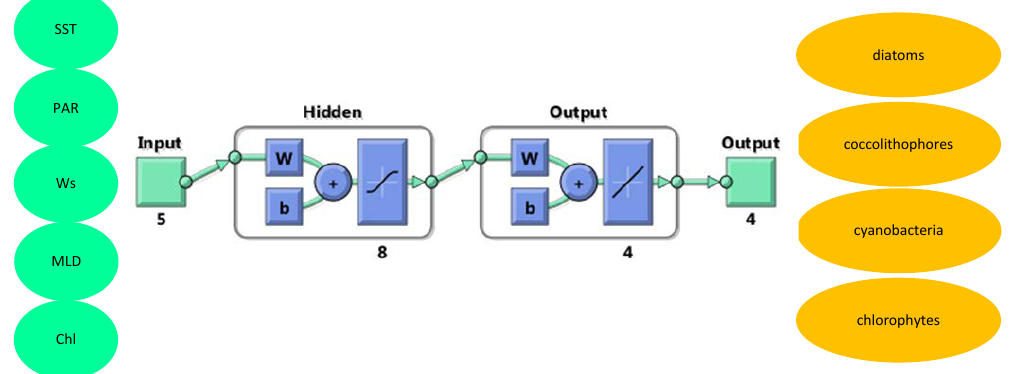
Fig. 2. A conceptual model illustrating how the ANN interprets the relationship between 5 (green circles), input variables, as well as between input and 4 target variables (yellow circles). Each hidden neuron in layer 1 computes the sum of input values multiplied by connection weights (w) and a bias term (b), and calculates the activation value of each neuron (being a nonlinear sum of all inputs). Each output neuron in layer 2 is a linear sum of the activation values from all layer 1 neurons multiplied by respective connection weights and a bias